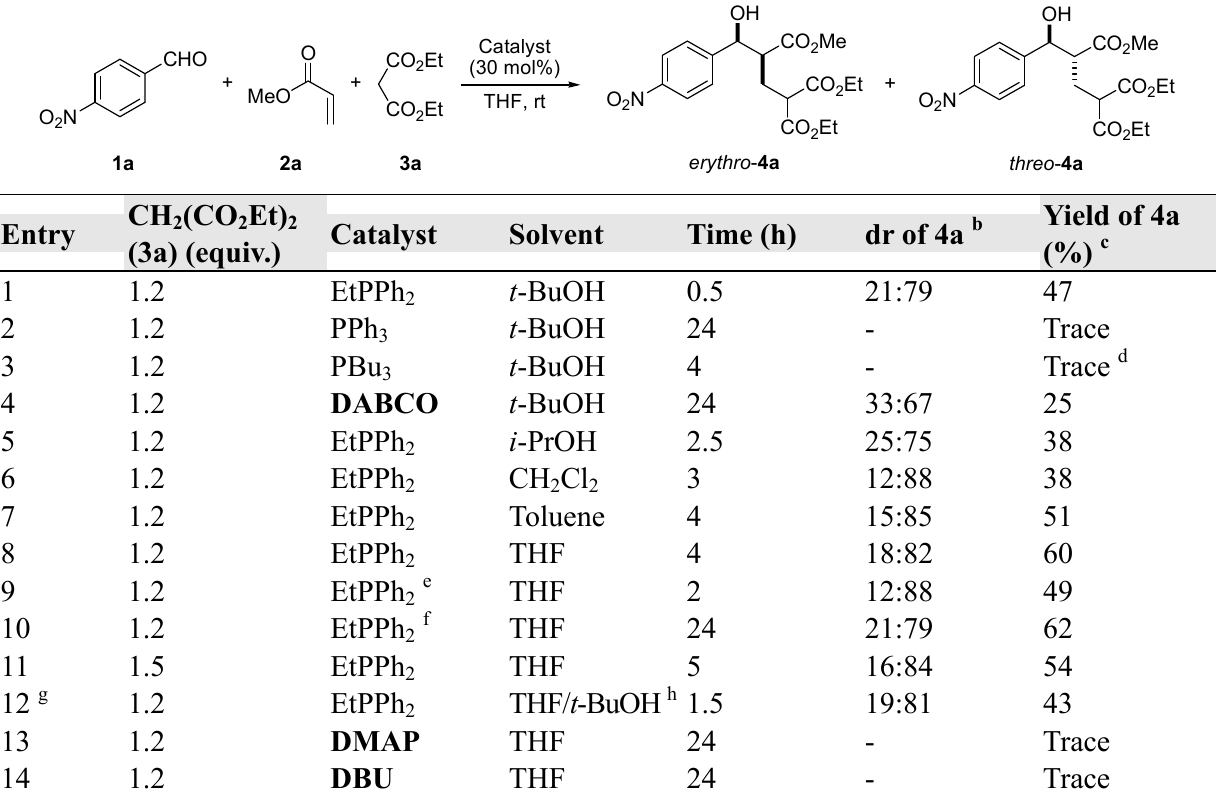
Table 1. Optimization of reaction conditions for a three-component reaction of 4-nitrobenzaldehyde ( 1a ), methyl acrylate ( 2a ) and diethyl malonate ( 3a ) catalyzed by different organocatalysts a